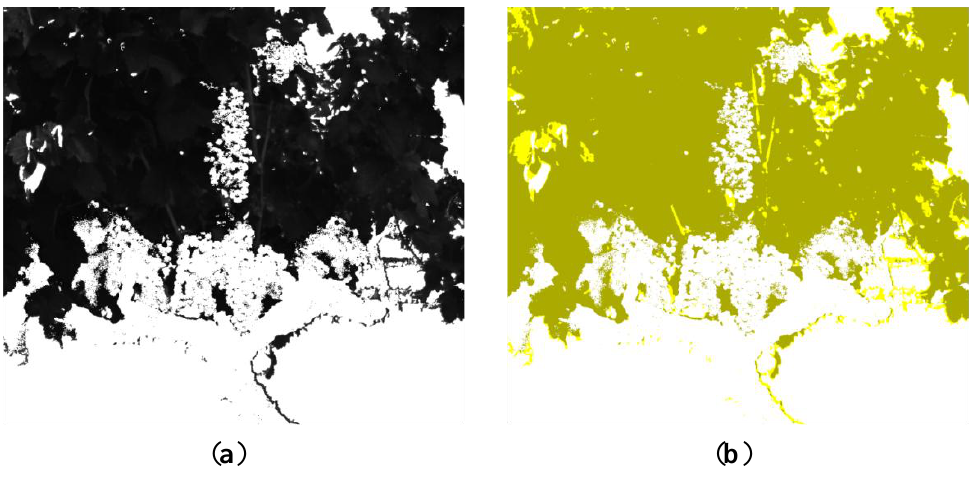
Figure 11. Step 10. ( a ) Original RGB image—scene 1; ( b ) Clustered image—scene